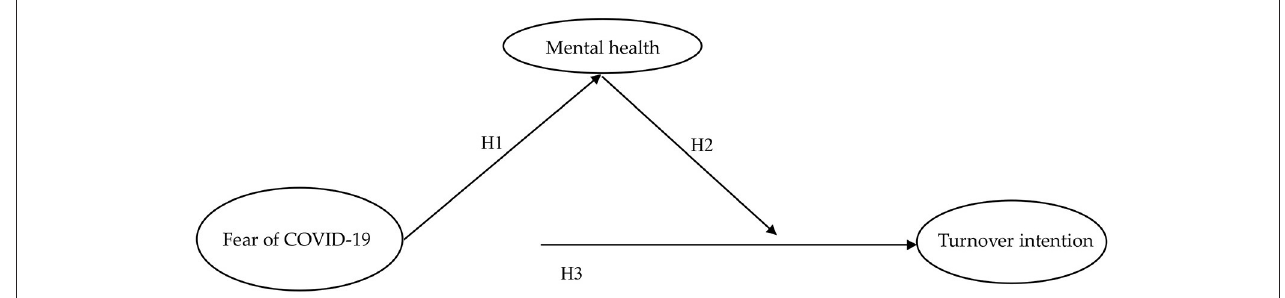
FIGURE 1 | Research conceptual model. Source: own research.